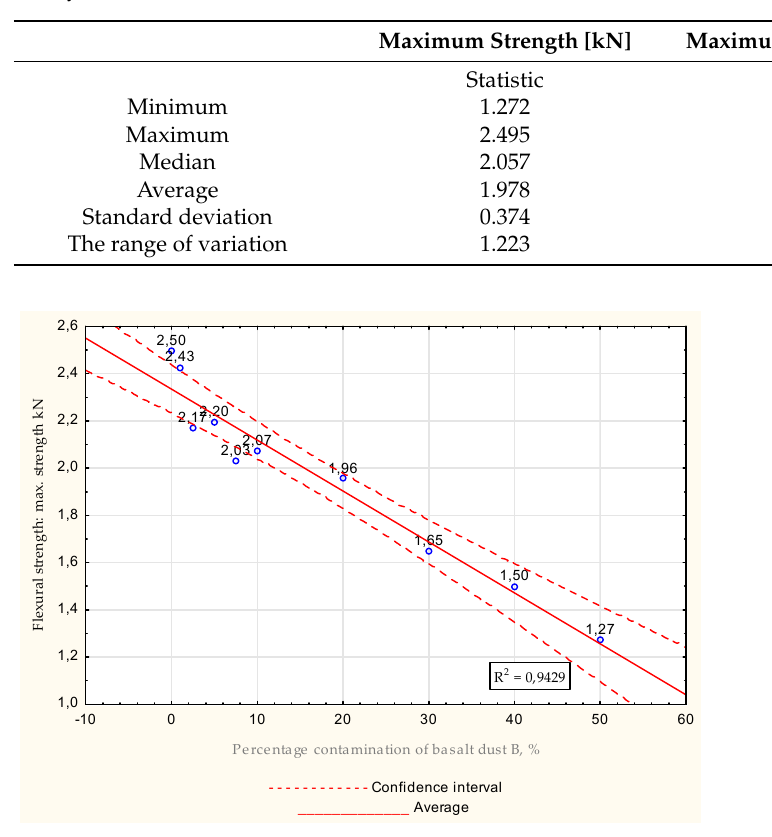
Figure 35. Average values obtained during flexural strength tests after 28 days for water − mix ratio = 0.7, maximal strength.